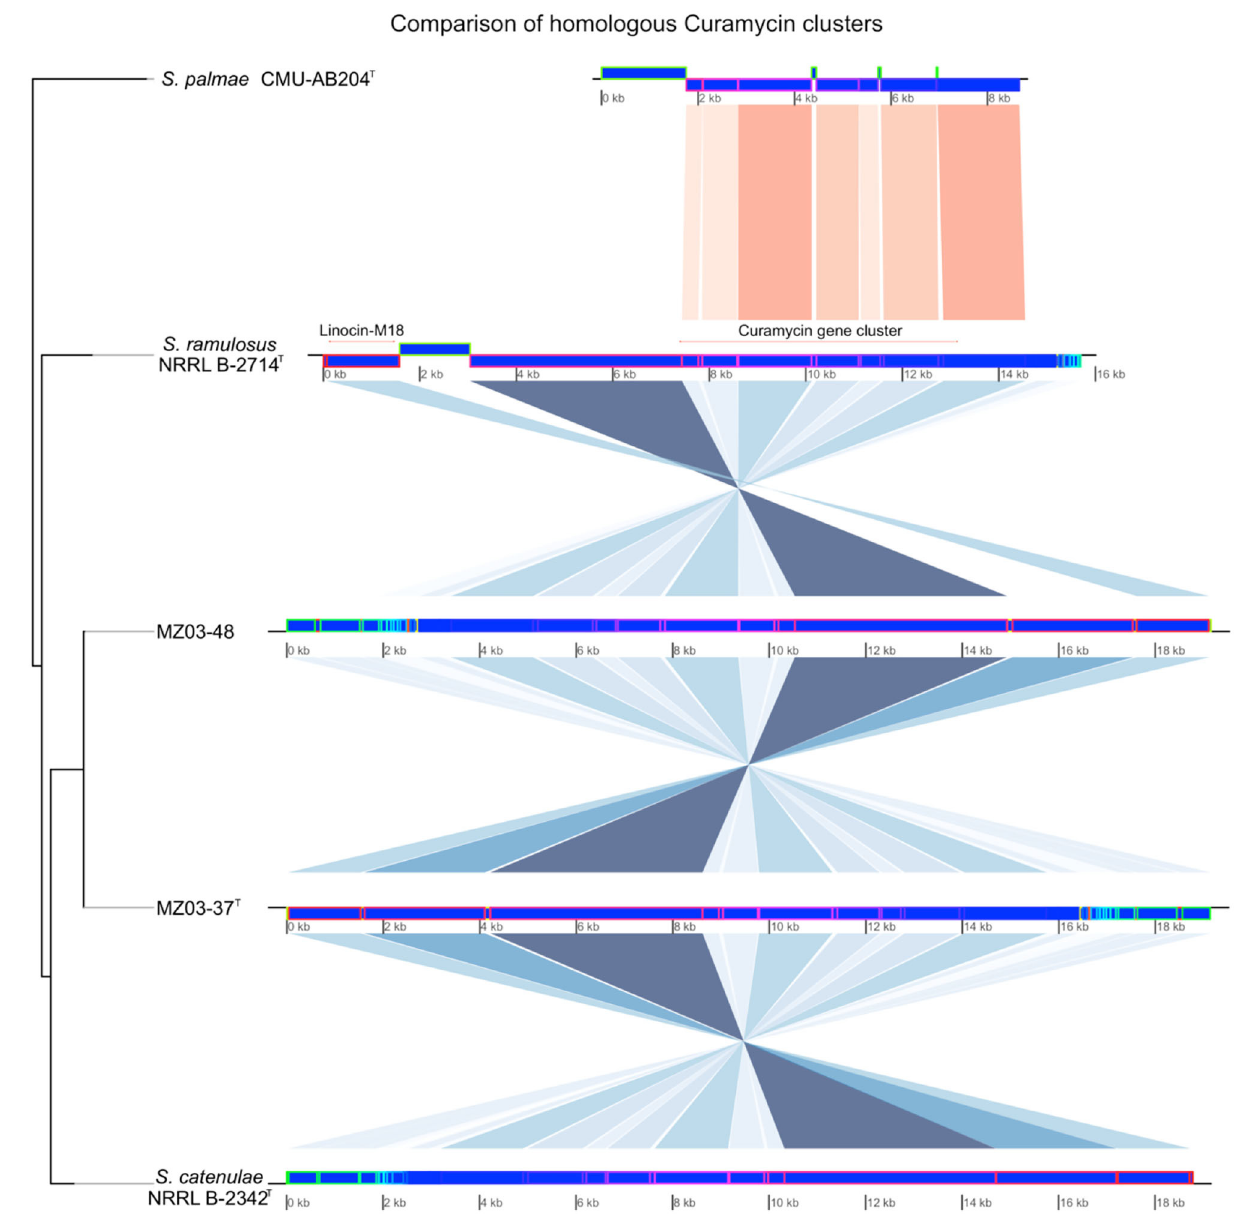
FIGURE 3 | Comparison of segments where Curamycin-Linocin-M18 gene clusters were predicted. Newick phylogenetic tree using Euclidean algorithm was built to determine the relatedness among contigs of the five bacteria. Conserved regions identified by MAUVE were represented with shades of blue and red.